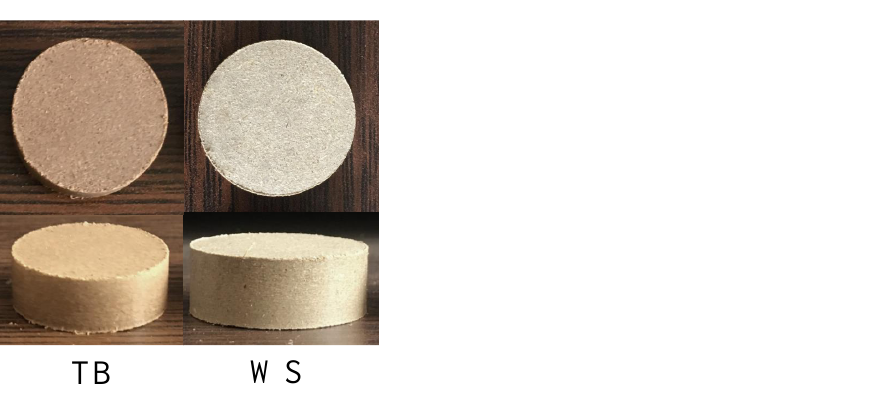
Figure 2. Photos of the Tree Bulk (TB) and Wheat Straw (WS) briquettes obtained from the tablet- ting process.